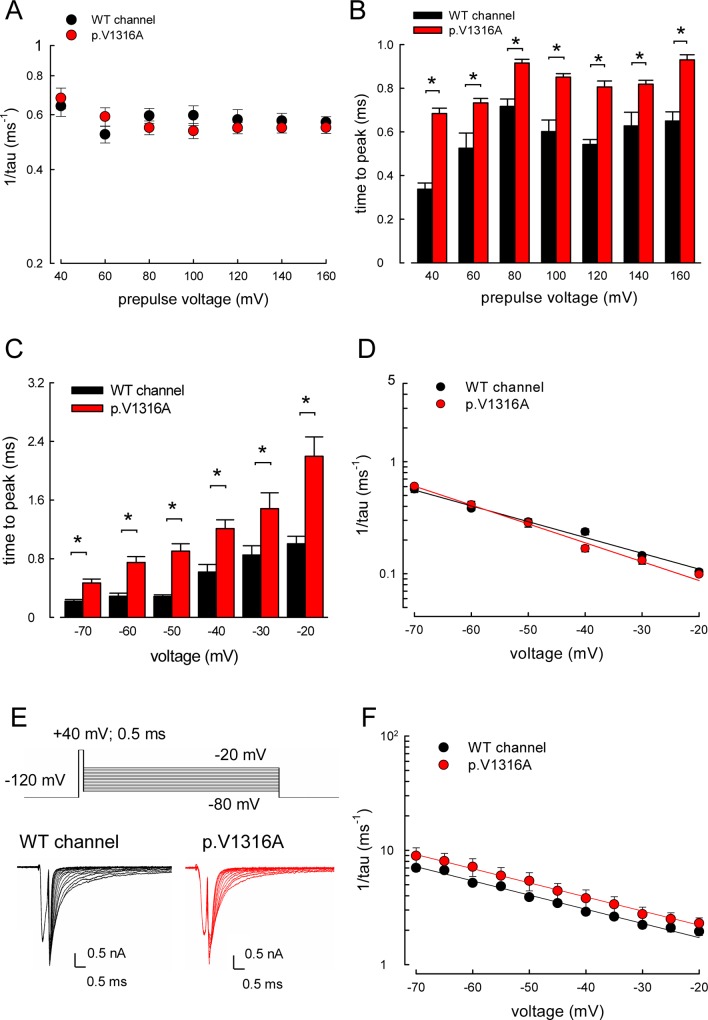
Monotonously accelerated decay of resurgent Na+ currents by membrane hyperpolarization in the WT and p.V1316A mutant channels.(A) Cumulative results were obtained with the same protocols described in Fig 6A (each n = 10). The inverses of decay time constants of the resurgent Na+ currents are obtained at –60 mV after prepulses of +40~+160 mV for ~10 ms in 20 mV increment for WT and p.V1316A mutant channels. Note that the inverse decay time constants are very similar in WT and p.V1316A mutant channels. (B) Cumulative results were obtained from the experiments described in part A (each n = 10). Note that the time to peak of the resurgent Na+ currents in the p.V1316A mutant channel is always slower than that in the WT channel at all of the prepulse voltages tested. *; p < 0.05. (C) The time to the resurgent Na+ current peak (the time from ending of depolarization prepulse of +40 mV to the resurgent current peak at different voltages) was measured with the same protocol in Fig 5 and plotted against the voltage of the resurgent pulse in the WT and p.V1316A mutant channels (each n = 10). Note trend of voltage dependence. Note that the time to the resurgent Na+ currents peak is evidently larger in the p.V1316A mutant than that of the WT channels with the repolarization potentials between –20 and –70 mV. *; p < 0.05. (D) The inverses of the time constants for the decay phase of resurgent Na+ currents (the same data as that in Fig 5, n = 10) was plotted against the voltage in semi-logarithmic scales for the WT and p.V1316A mutant channels. The lines are linear regression fits of the form: 1/tau(V) = 0.06×exp(–0.81V/25) ms-1 for WT channel and 1/tau(V) = 0.04×exp(–0.97V/25) ms-1 for p.V1316A mutant channel, respectively, where V is the membrane potential in mV. The inverses of time constants of decay kinetics in the resurgent currents are very similar in the WT and p.V1316A mutant channels. (E) The cells were held at –120 mV and stepped to +40 mV for 0.5 ms of depolarization (the activation pulse), and following by repolarization from –80 mV to –20 mV for ~20 ms (the deactivation pulse) in the WT and p.V1316A mutant channels. The tail currents show faster decay kinetics as the deactivating pulse goes more negative. (F) The decay phase of tail currents in part E is fitted by mono-exponential functions for different deactivating potentials in the WT and p.V1316A mutant channels. The inverses of time constants of decaying phase in tail currents are plotted against voltage in semi-logarithmic scales for WT and p.V1316A mutant channels (n = 10). The lines are linear regression fitted of the form: 1/tau(V) = 0.97×exp(–0.72V/25) ms-1 for WT channel, and 1/tau(V) = 1.25×exp(–0.71V/25) ms-1 for p.V1316A mutant channel, respectively, where V is the membrane potential in mV. Note that the inverses of time constants of decay kinetic phases in the tail currents are very similar in the WT and p.V1316A mutant channels. Individual data is shown in the file of S1 Data.